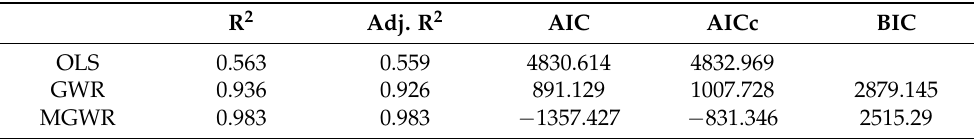
Table 3. Comparison of Regression Diagnostic Information.